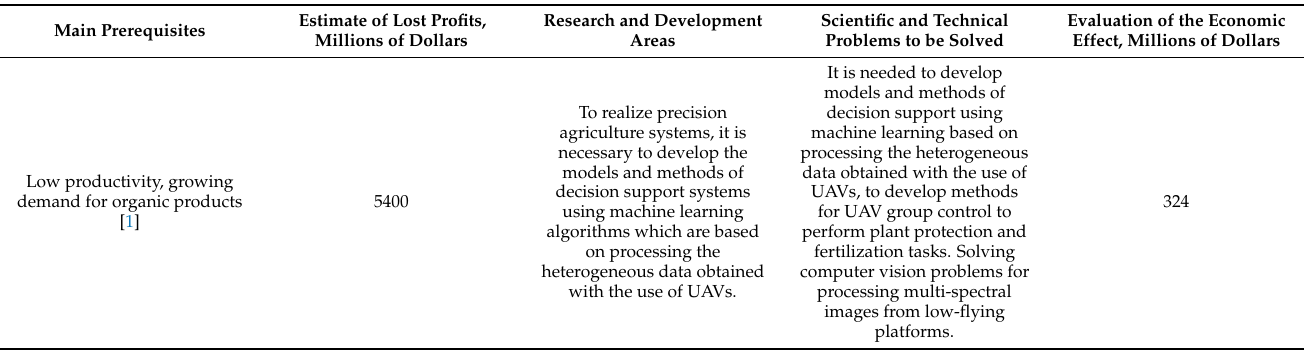
Table A2. IUAVT use for precision agriculture.